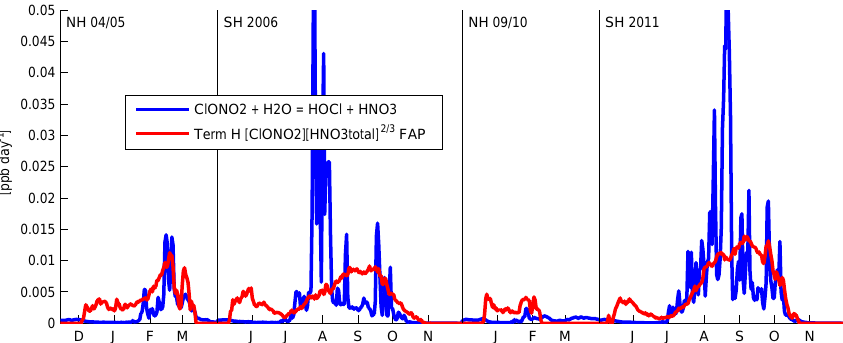
Figure 12. Fit of term H for the Arctic winter 2004/2005, the Antarctic winter 2006, the Arctic winter 2009/2010 and the Antarctic win- ter 2011 at 54hPa. Vortex-averaged reaction rate modeled by ATLAS for the reaction ClONO 2 + H 2 O (blue) and the fitted term H (red). Tick marks on the horizontal axis show start of months.